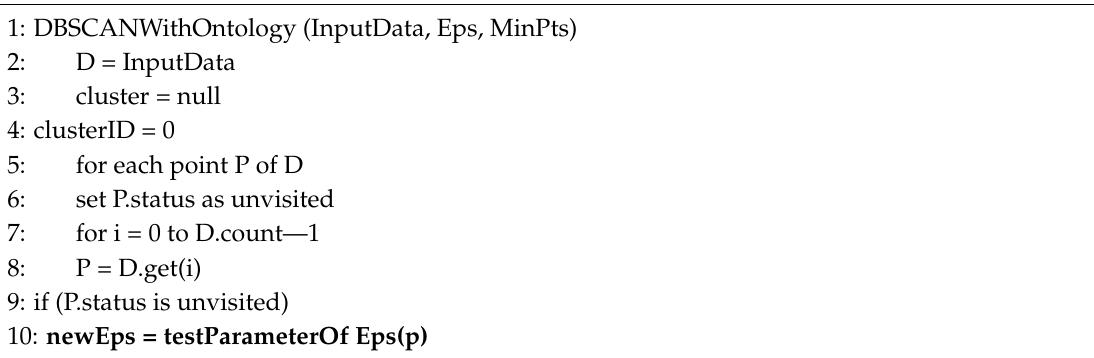
Figure 12. Overall flow of the reasoning process for determining Eps and MinPts . Algorithm 3. DBSCAN algorithm with ontology-based background knowledge.